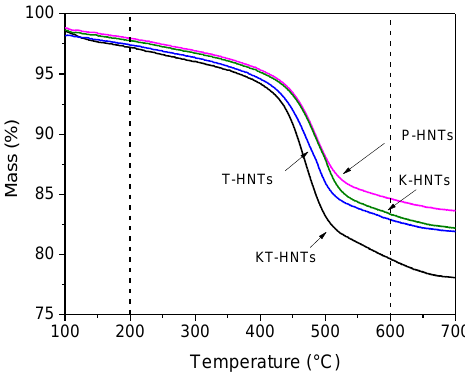
Figure 1. TGA curves of P-HNTs, K-HNTs, T-HNTs, and KT-HNTs.